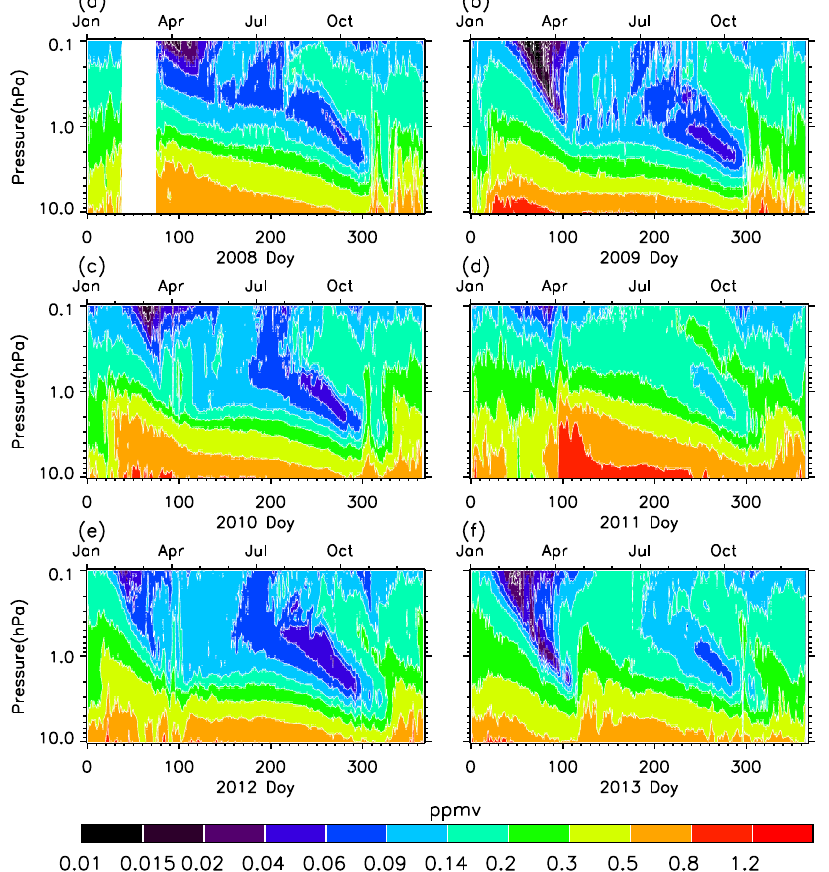
Figure 1. Overview of upper stratospheric and lower mesospheric zonal mean CH 4 observed by SOFIE for the indicated years. SOFIE observes at only one latitude per day in each hemisphere. This latitude has some variation from year to year, but is typically near 82 ◦ at the equinoxes and near 65–66 ◦ at the solstices. The horizontal axis label, doy, is day of